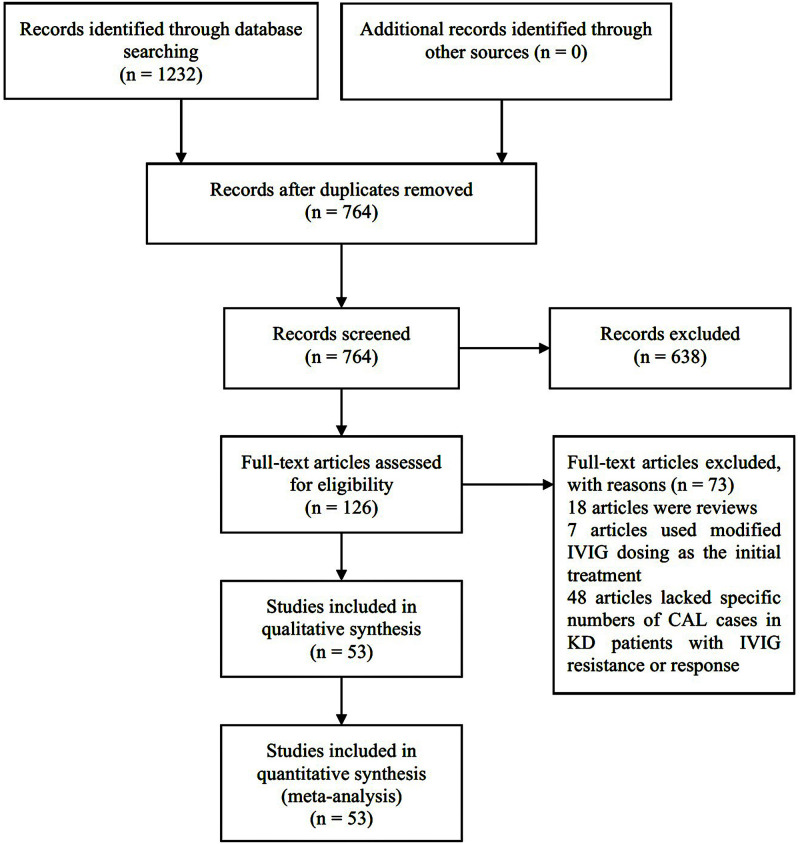
Flowchart of the study selection process.